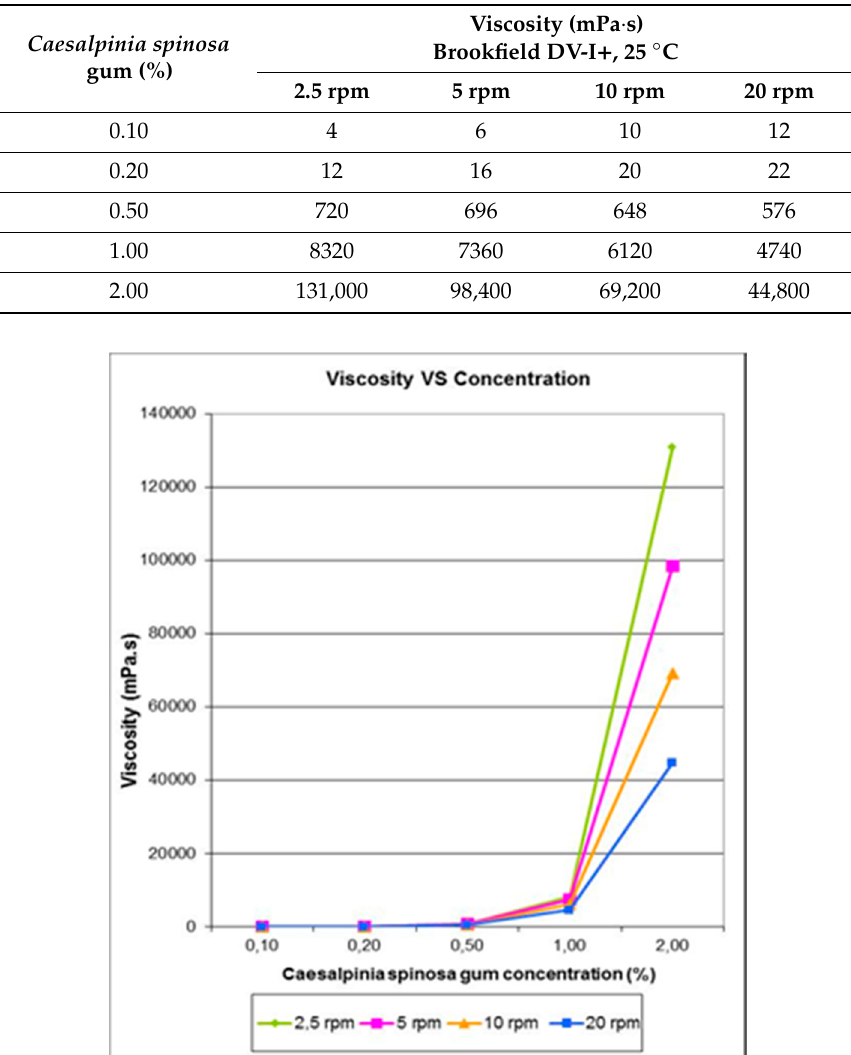
Figure 6. Caesalpinia spinosa gum viscosity at di ff erent